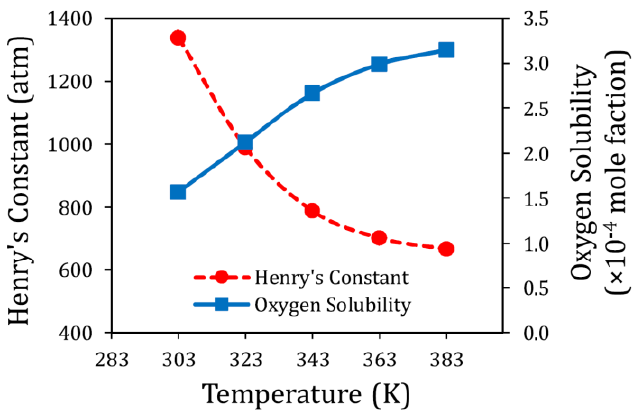
Figure 39. The variance of Henry’s constant and solubility of oxygen (×10,000 mole fraction) with temperature are shown. The Henry’s constant decreases with temperature. Reprinted from Yoo et al. [44], with permission from Elsevier.